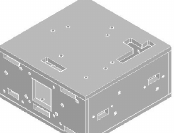
Figure 3. Base isometric CAD drawing.